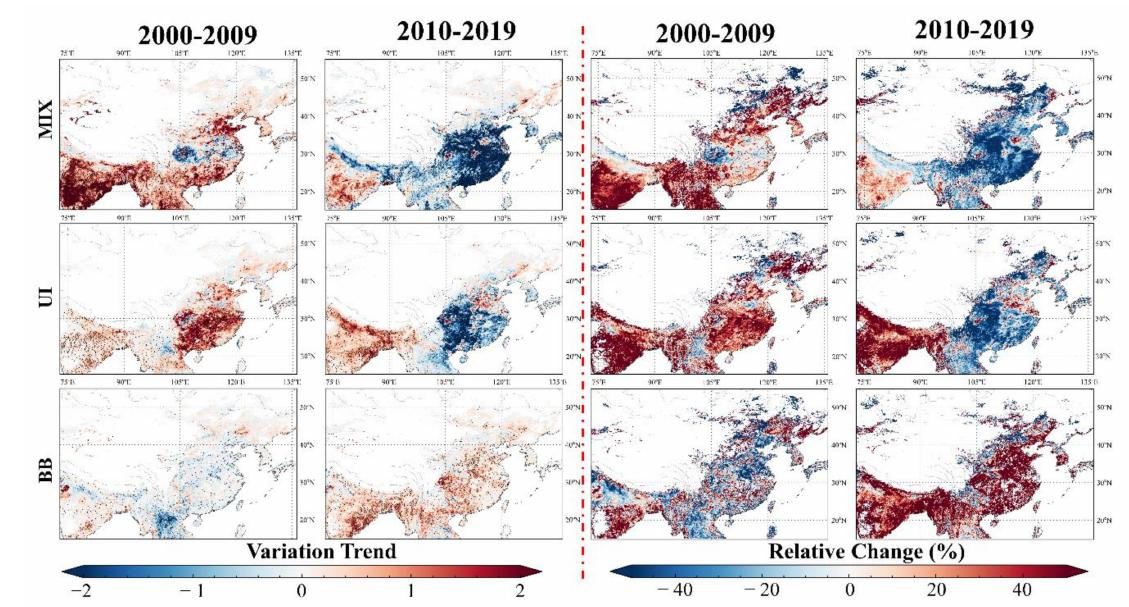
Figure 10. Relative change and variation trend of five aerosol type proportions using MODIS dataset during